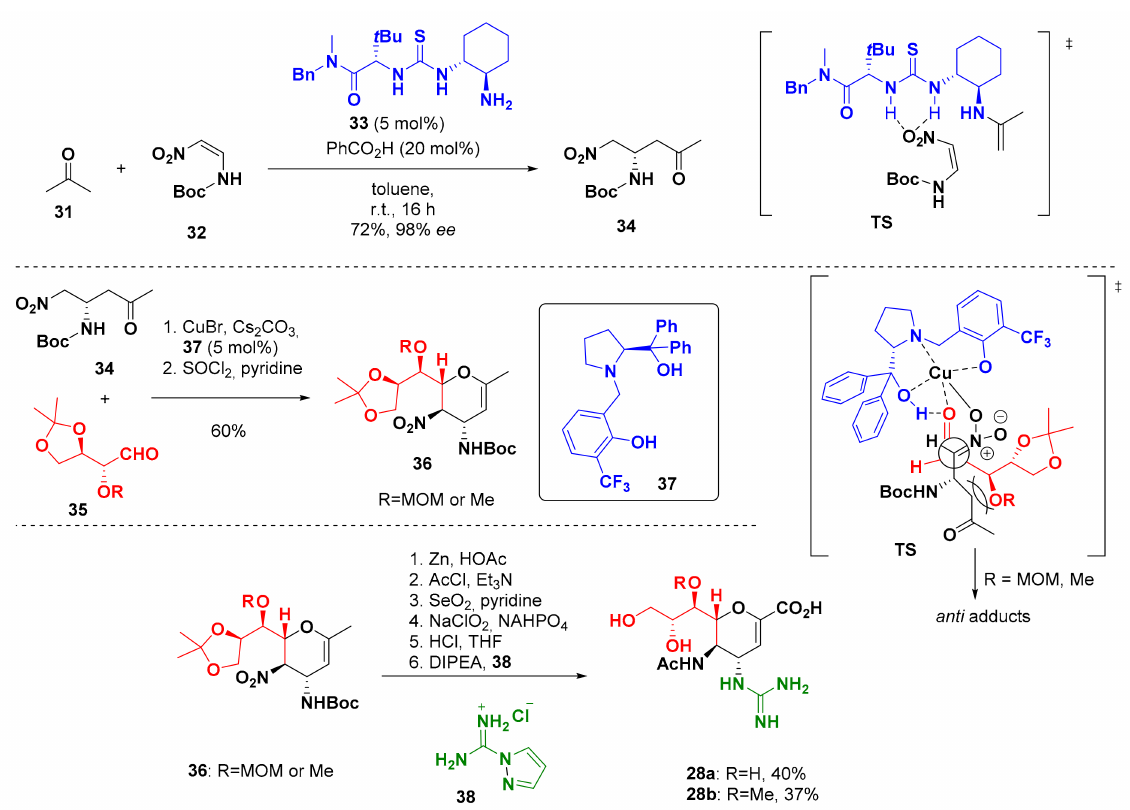
Scheme 7. Total synthesis of zanamivir starting from D-araboascorbic